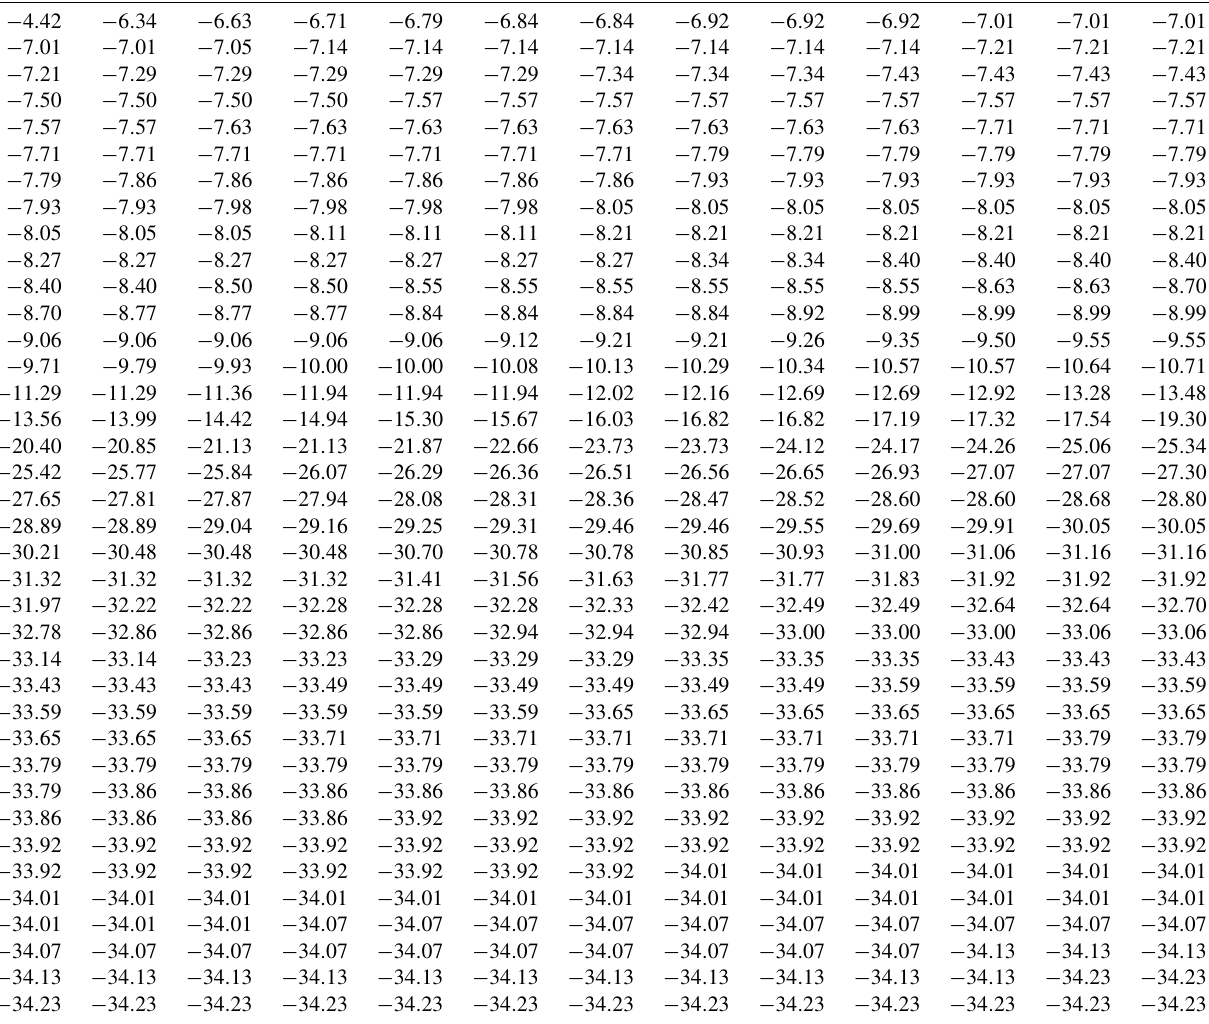
Table 1. Observed freezing temperatures for 507 drops of a sample of Snomax TM dispersed in purified water. Freezing temperatures are listed in decreasing order. Multiple values are due to time steps of the detection system used. These data are from work described in Polen et al.